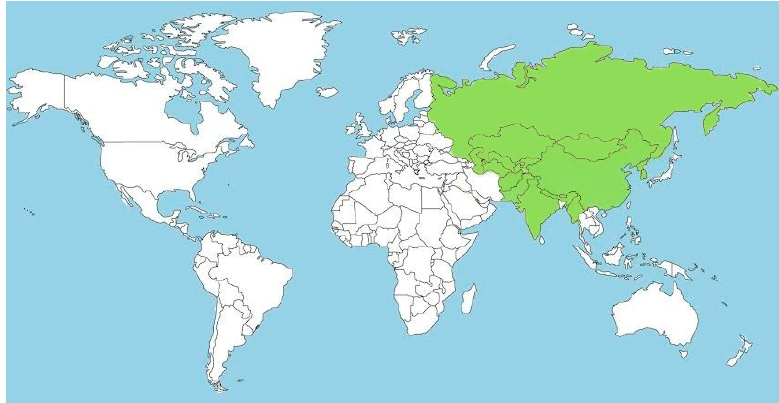
Figure 1. A world map showing the geographical distribution of Bergenia species (in green).